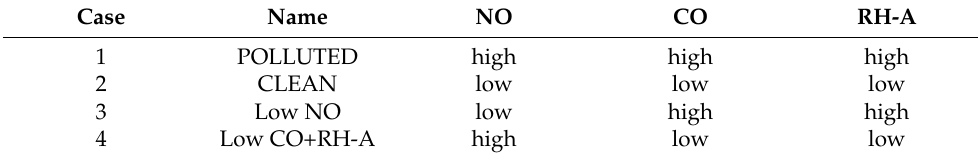
Table 1. Emissions of NO, CO, and RH-A for different model